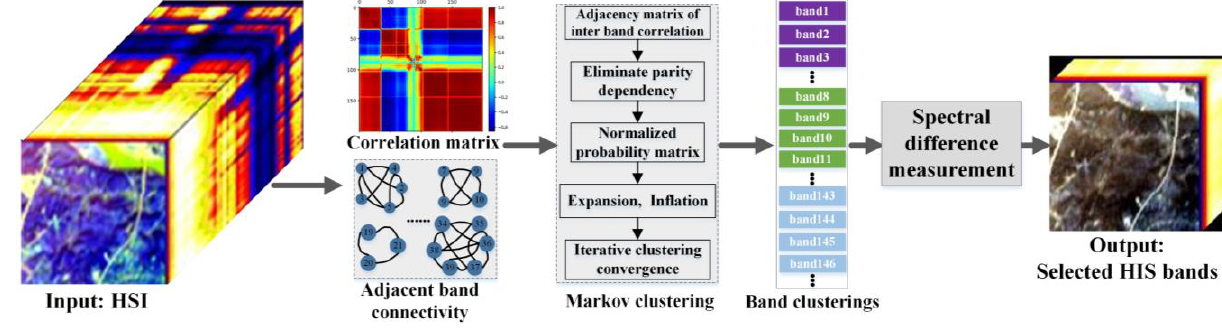
Figure 1. The flow chart of the MCLSD method.